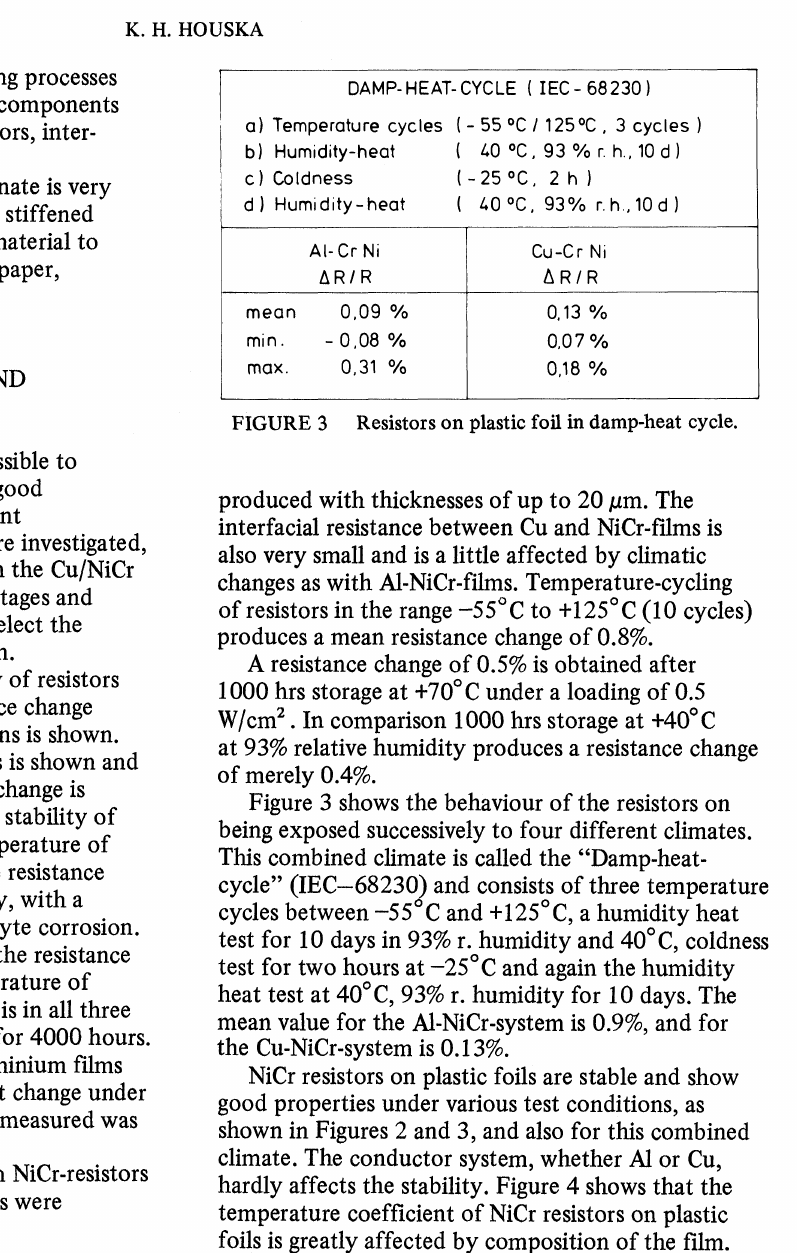
Long-term stability of CrNi-films.